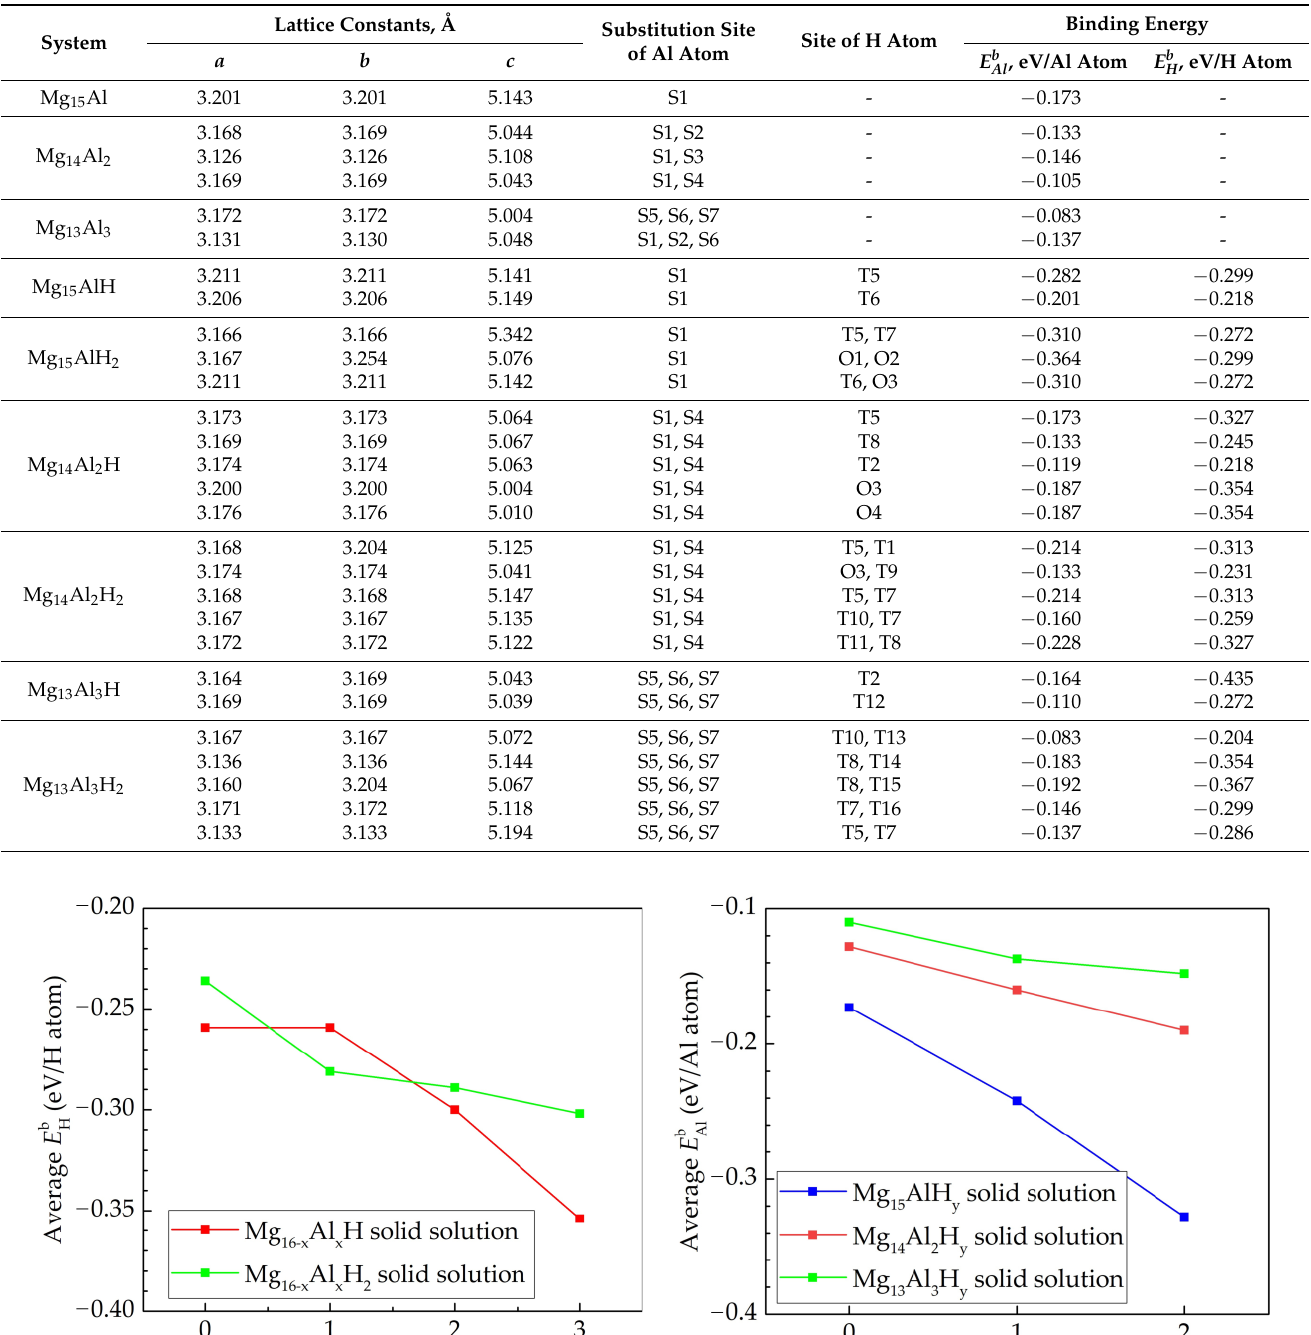
Table 3. The binding energy of hcp Mg 16 − x Al x H y , x = 1, 2, 3, y = 0, 1, 2.